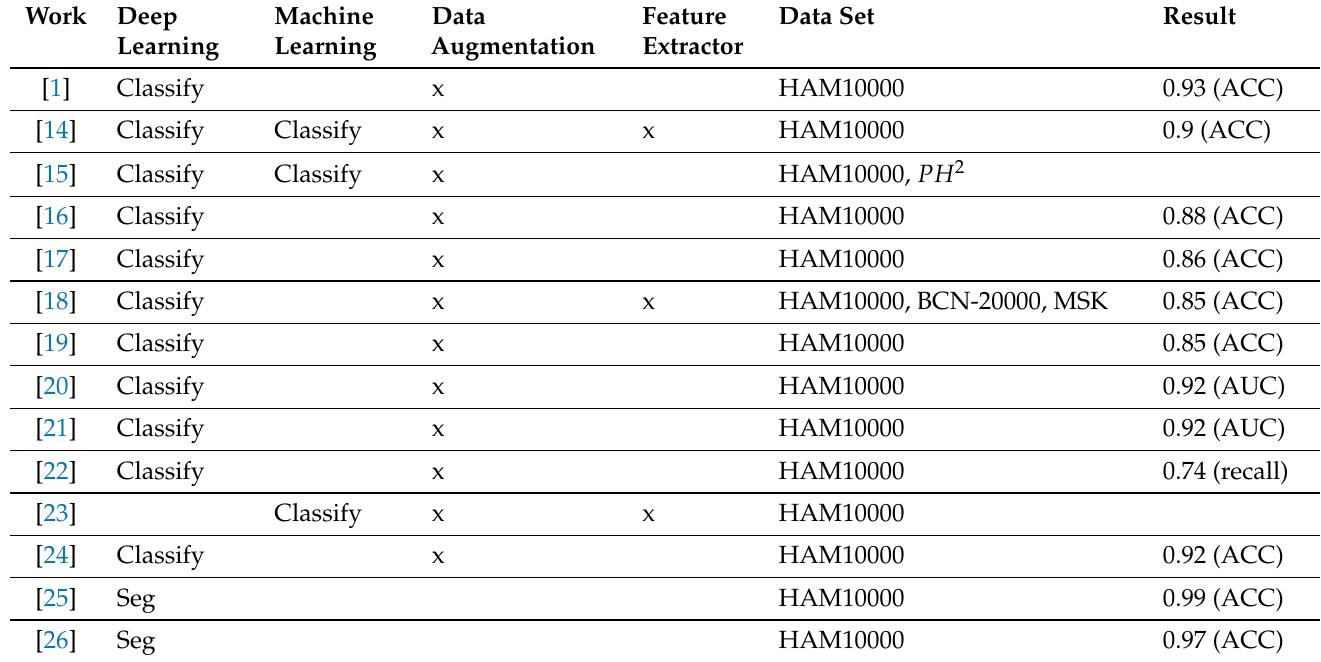
Table 1. Summary of related